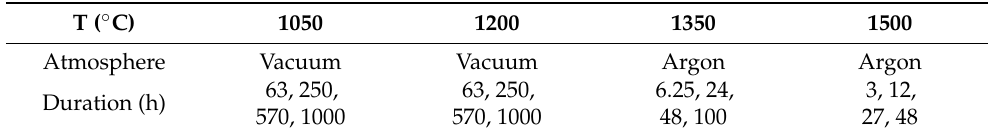
Table 3. Annealing treatment conditions were conducted on both sandwich cladding and diffusion couple